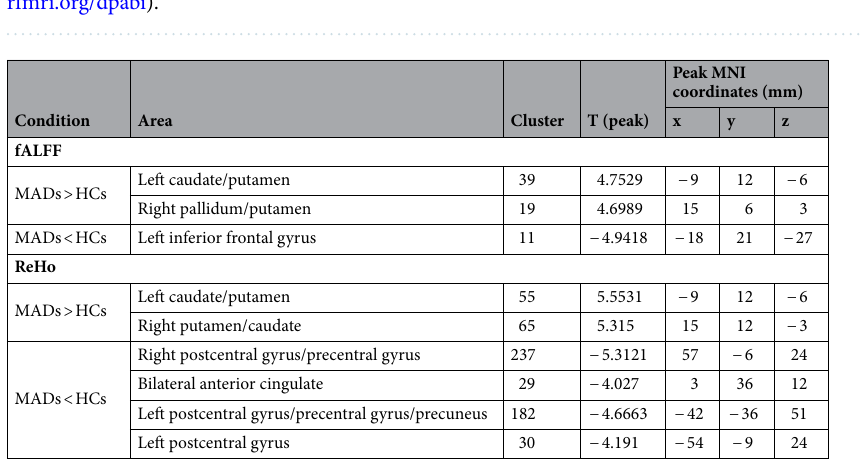
Figure 1. fALFF analysis. Two-sample t-test results are presented, voxel-level p < 0.001, cluster level p < 0.05, two-tailed, voxel size > 9, corrected by GRF. The area in blue represents significantly decreased ALFF value; the area in yellow and red represents significantly increased fALFF value. Created with DPABI_V4.3_200401 (http:// rfmri. org/ dpabi).